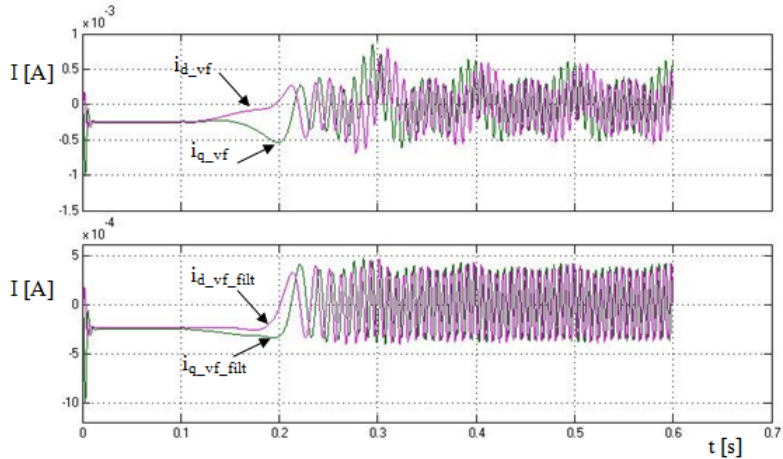
Figure 20. Position signal in dq system prior to and after filtration.